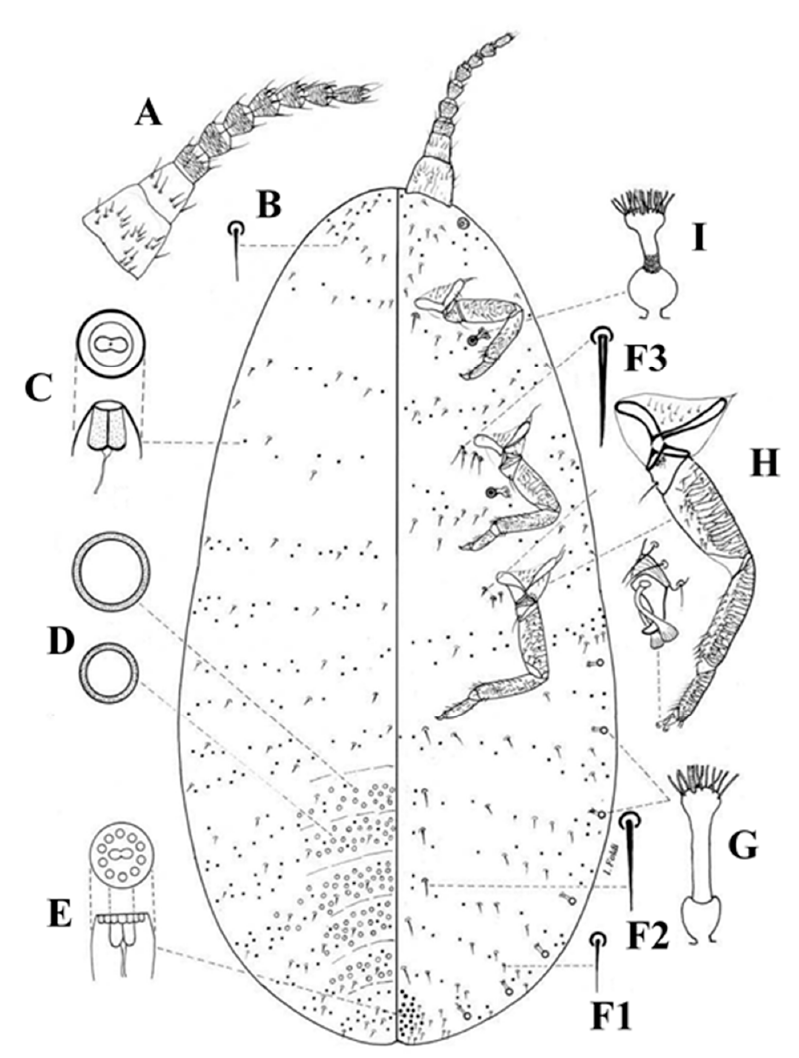
Figure 3. Matsucoccus matsumurae (Kuwana, 1905), adult female, from Foldi [5]. A , antenna; B , dorsal seta; C , bilocular tubular duct; D , cicatrices; E , multilocular disc-pore; F1–3 , ventral setae; G , abdominal spiracle; H , leg; I , thoracic spiracle. This figure was reproduced with permission of I. Foldi.